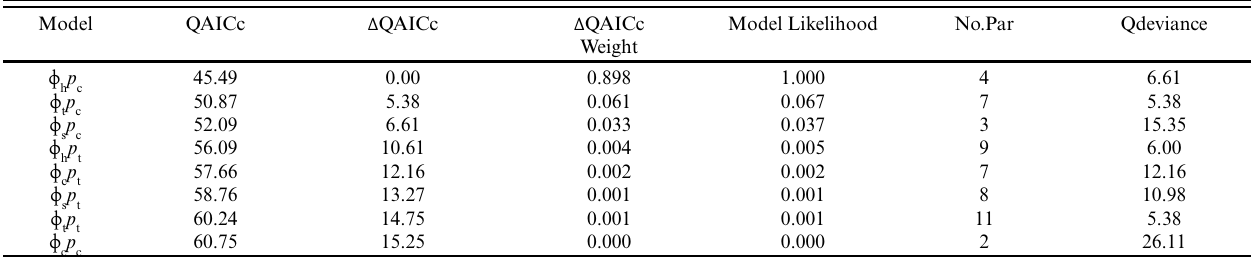
Table 2 . Evaluation of Cormack-Jolly-Seber models for monthly survival of Black-headed Bunting ( Emberiza melanocephala ) males in 2011–2013. Models evaluated whether monthly survival rates ɸ varied with time (t), between breeding and nonbreeding season (s), and presence of Montagu’s Harrier ( Circus pygargus ) in the study site (h) as well as whether resighting rates p were constant (c) or varied with time (t). Models are ranked according to QAICc value.